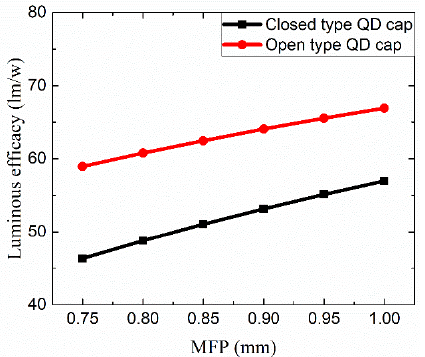
Figure 6. The dependence of the luminous efficacy as a function of the mean free path (MFP) of red QDs in the cap for the two designs, i.e., the open cap structure and the closed cap structure.